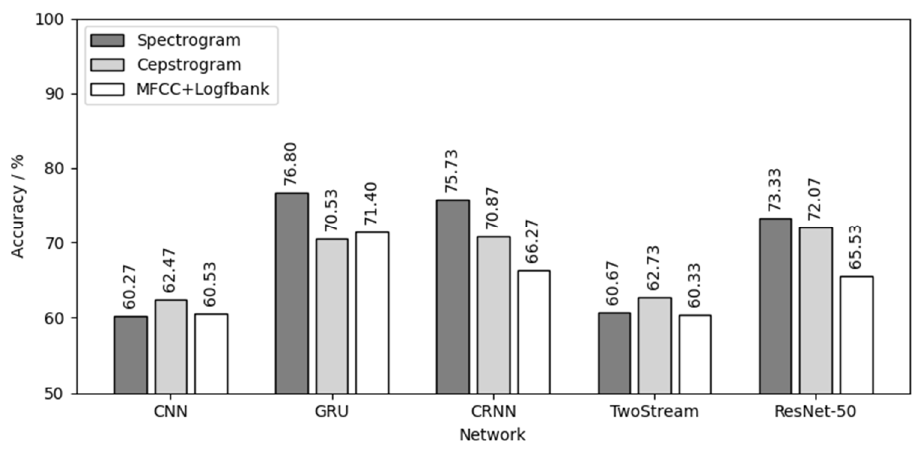
Figure 17. Native chick calls for both training and testing.